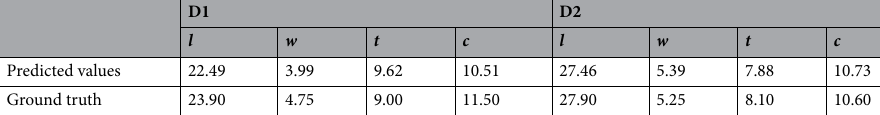
Table 2. Predicted vs ground truth (actual) values of SRR geometrical parameters. All values are in micrometers. D1 and D2 are randomly selected geometries from the test set.